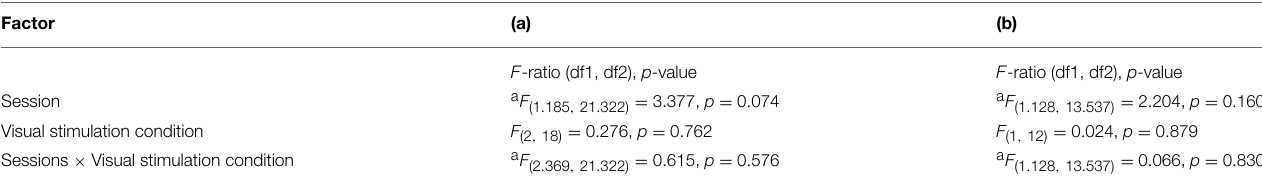
TABLE 2 | Results from repeated measures analyses of the head movement for (a) eccentricity, polar angle and full field and (b) eccentricity and polar angle. Factor (a)